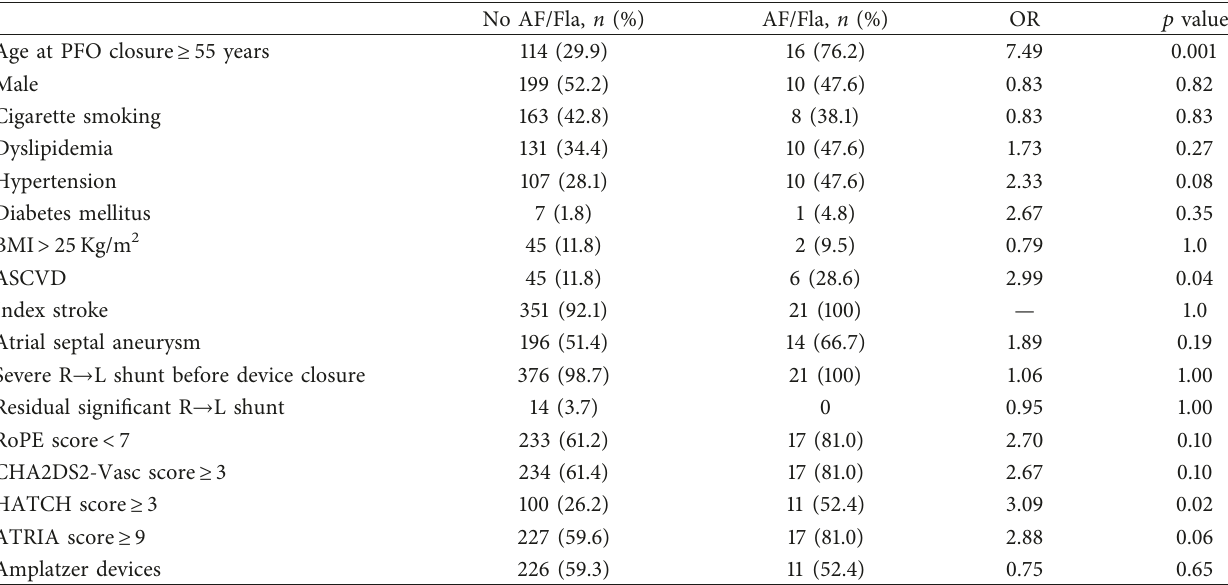
Table 6: Predictors of AF or atrial flutter diagnosis on follow-up.